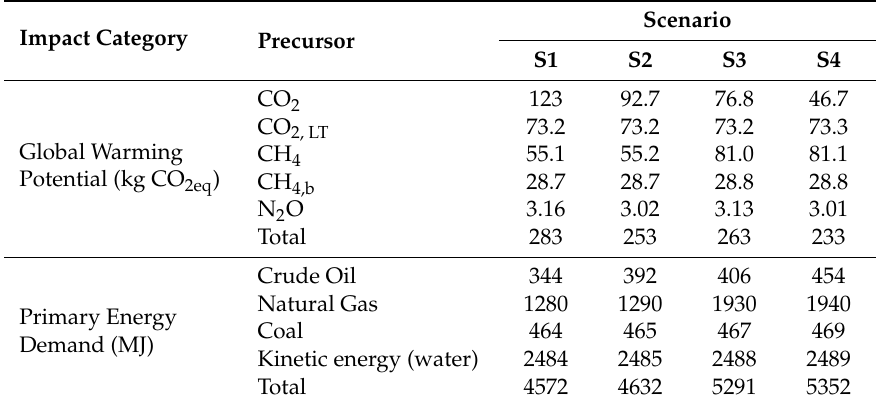
Table 6. Environmental and Energy Performance and main specific contribution for the of 1.0 MWh of electricity using the Brazilian